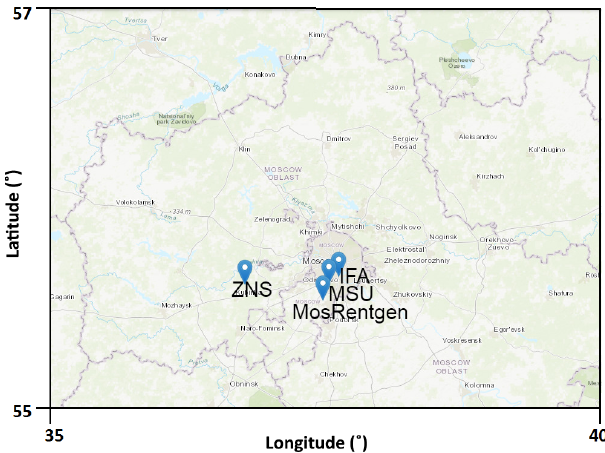
Figure 1. Location of microbarographs in the Moscow